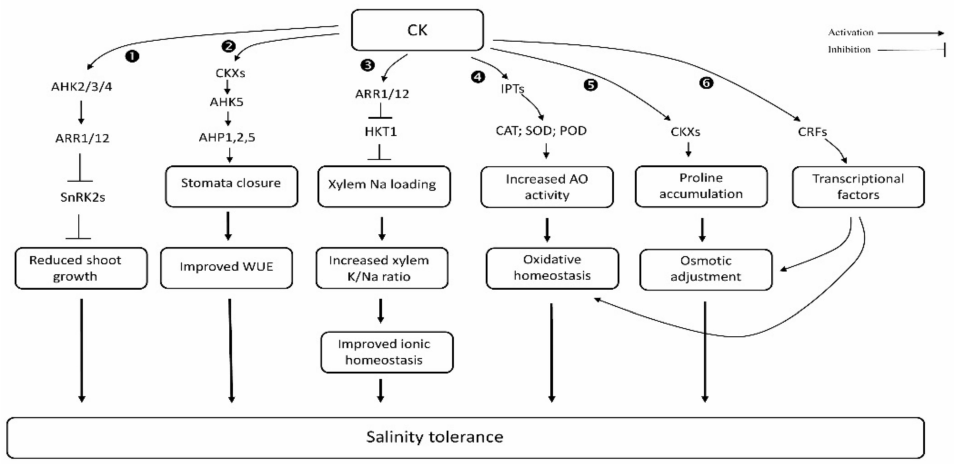
Figure 1. Effect of cytokinin on salt stress tolerance in plants (based on (cid:182) [115,130], (cid:183) [131], (cid:184) [127,132], (cid:185) [133], (cid:186) [134], and (cid:187)